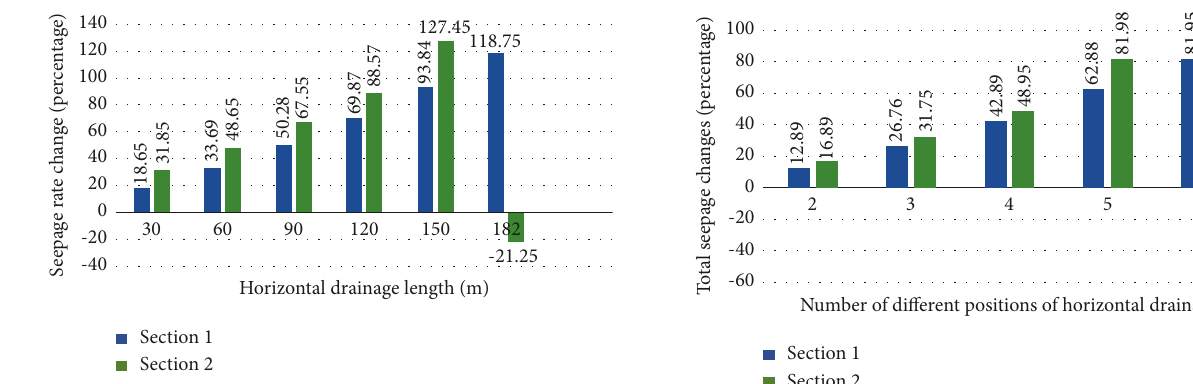
Figure 12: Percentage of seepage changes in Sections 1 and